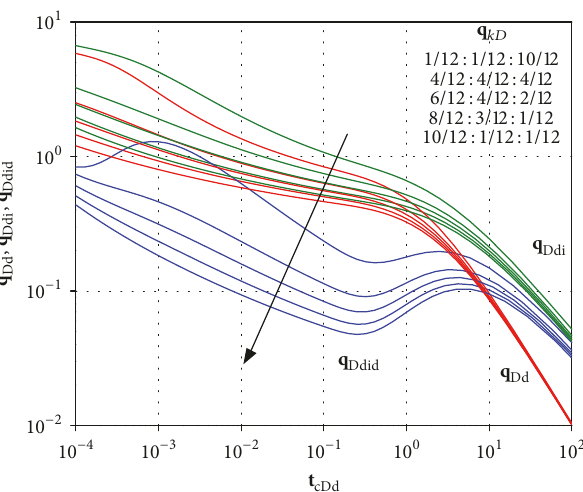
Figure 6: The effect of length of two sections on type curves.